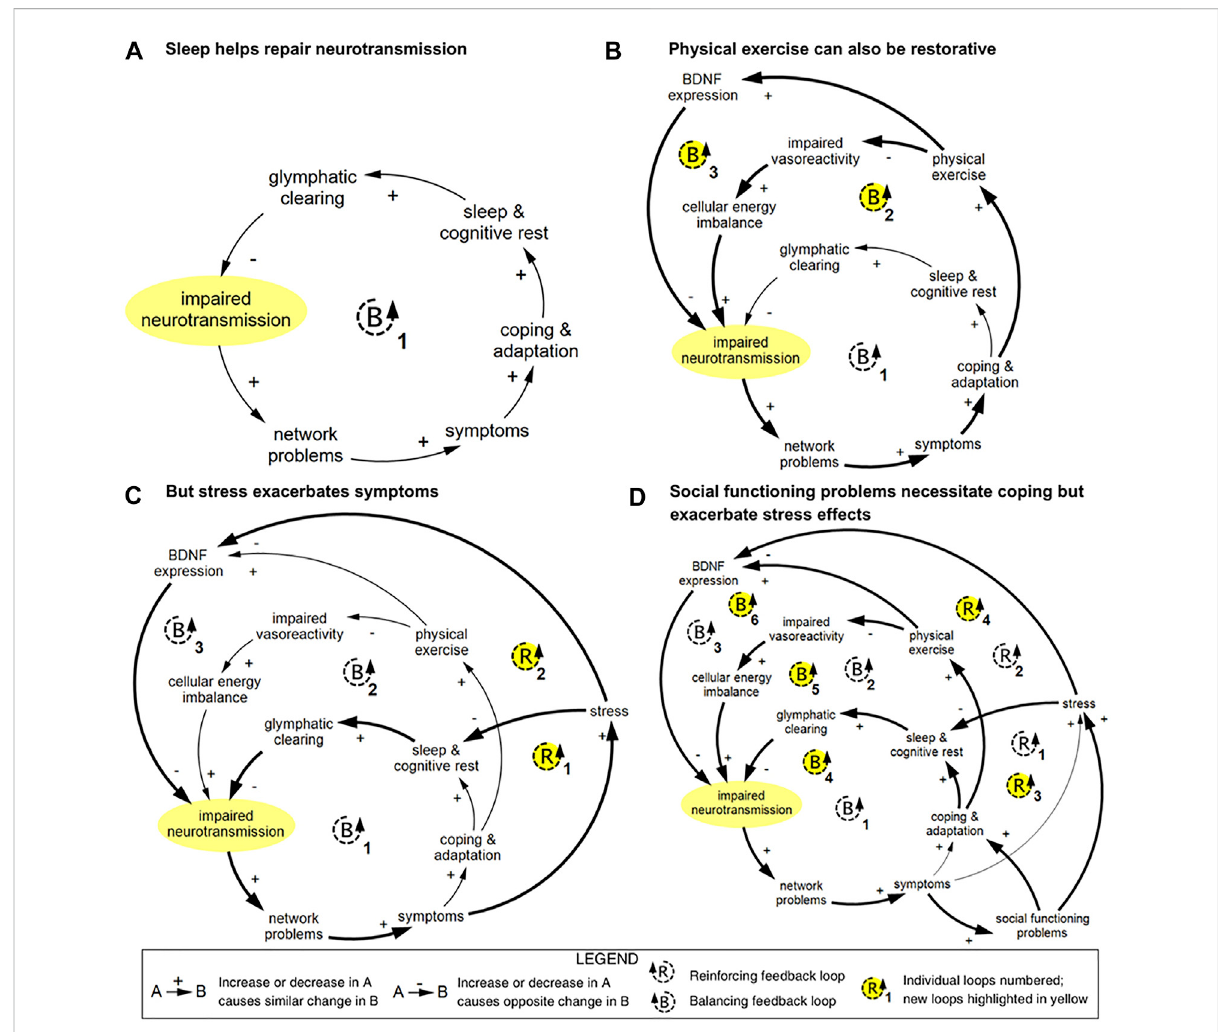
FIGURE 1 Exampleofcausal-loopdiagramshowingfeedbackloopspertainingtoimpairedneurotransmissioninTBI,reproducedfromKenzieetal.(2018). This series of diagrams illustrates how connected loops can have compounding and counteractive effects. (A) In loop B1, impaired neurotransmission affects the function of networks; these networks and network functions include limbic, intrinsic connectivity networks,